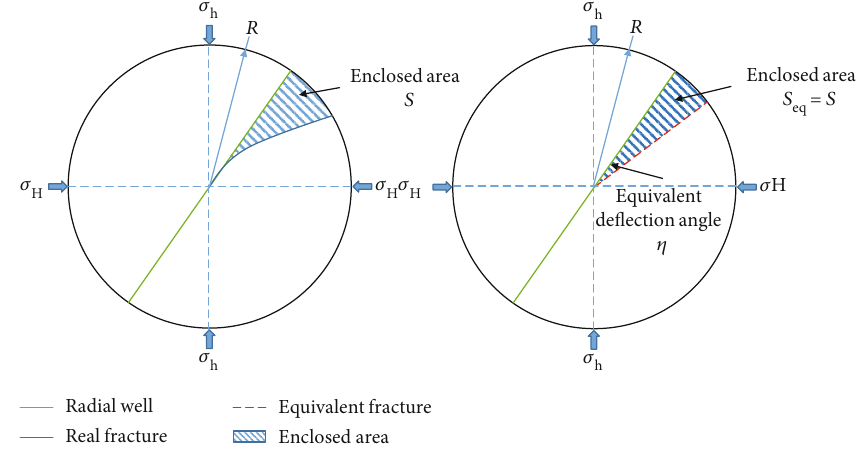
Figure 3: Sketch of equivalent fracture.